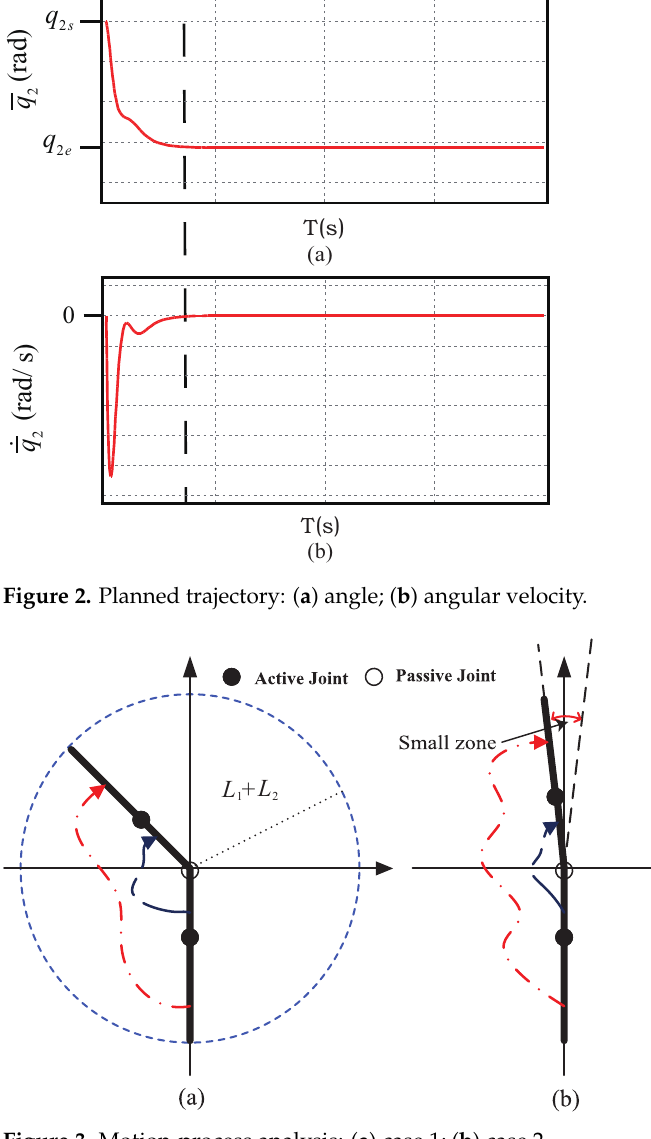
Figure 3. Motion-process analysis: ( a ) case 1; ( b ) case